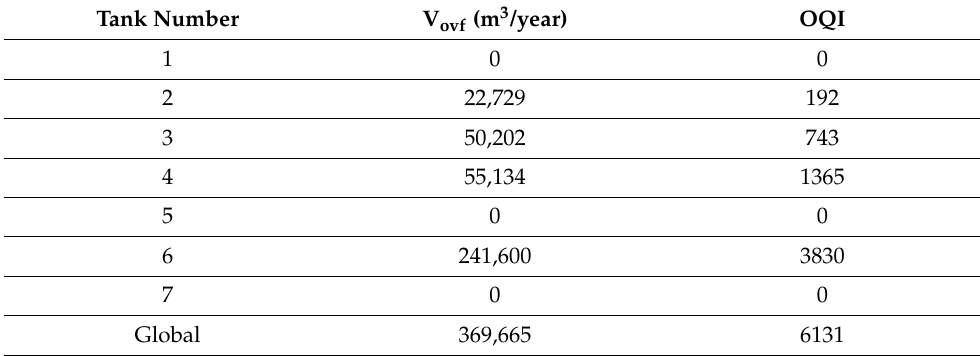
Table 6. Simulation results (no control is taken into account).